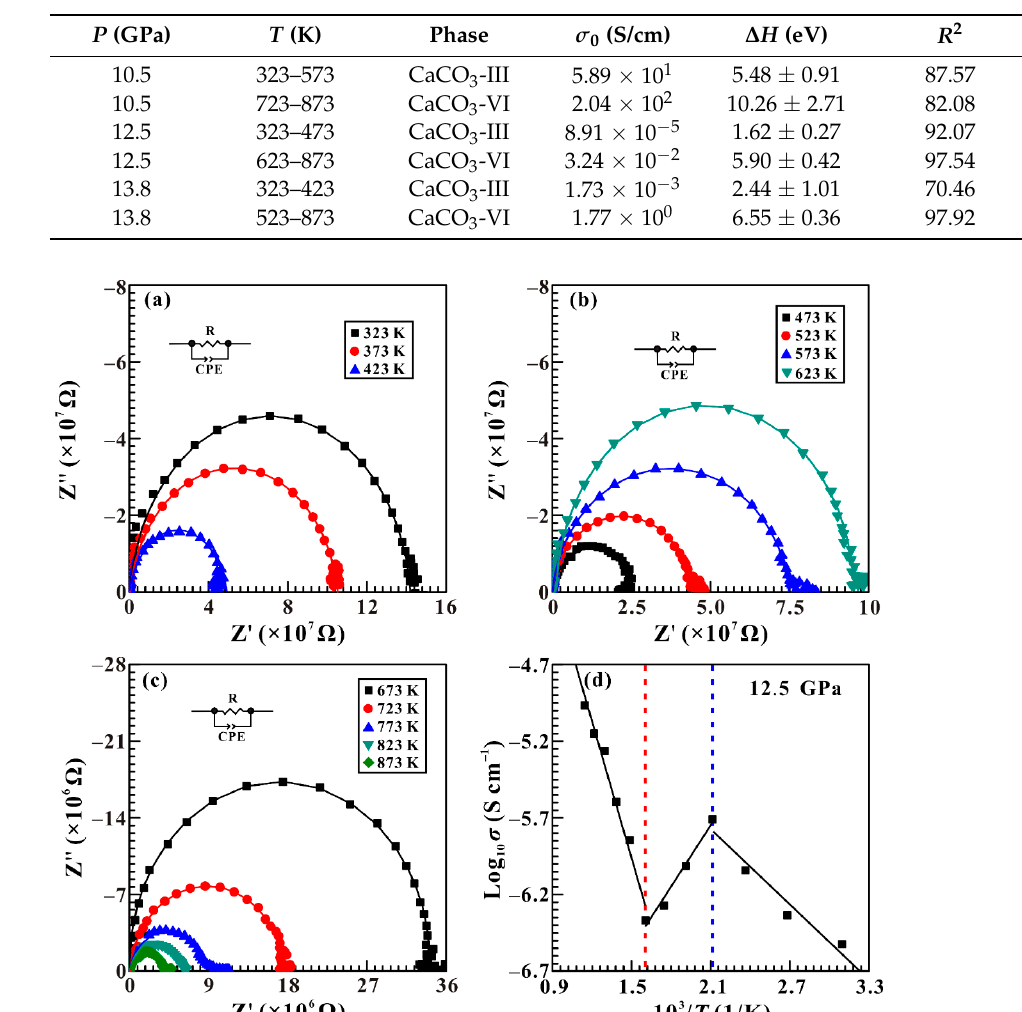
Figure 8. Complex impedance spectra of calcite in the temperature range of 323–873 K at 12.5 GPa. ( a ) 323–423 K; ( b ) 473–623 K; ( c ) 673–873 K. ( d ) The logarithmic electrical conductivity of calcite against reciprocal temperature. Z’ is the real part of the complex impedance spectra and Z” is the imaginary part. The colored curves are the results of the fitting to the impedance spectra. The black solid lines are obtained from the Arrhenius fitting results of the data.